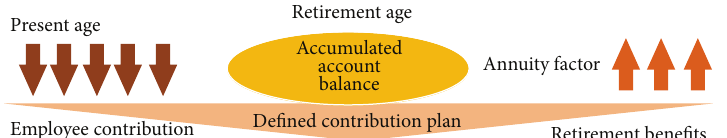
Figure 1: Defined Contribution Plan Mechanisms. Resource: Model Calculation Analysis.